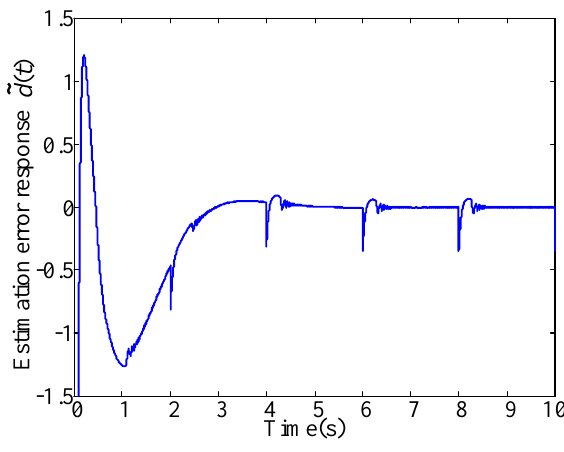
Figure 11. Estimation error response of SMO.